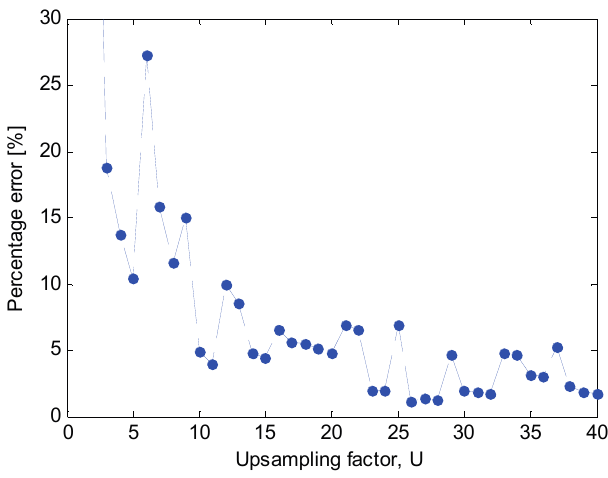
Figure 16. Distortion of beam pattern (measured in terms of the percentage error ∑ ) for beamforming with optimum complex weights versus the upsampling factor U